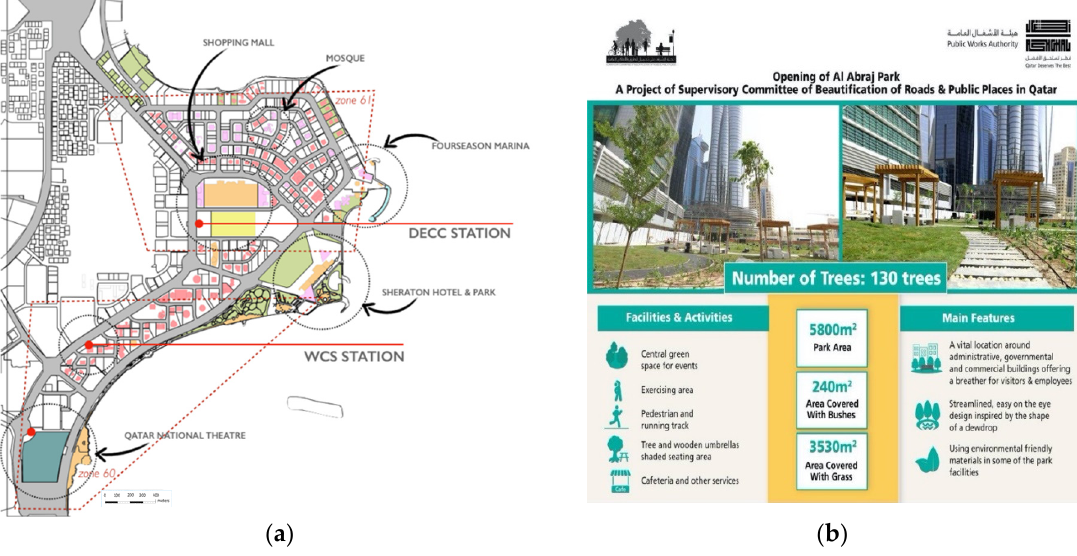
Figure 6. ( a ) West Bay Doha landmarks; ( b ) public space in West Bay Doha [32].